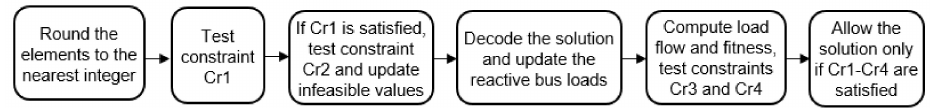
Figure 10. Fitness computation and solution validation for the OCBA